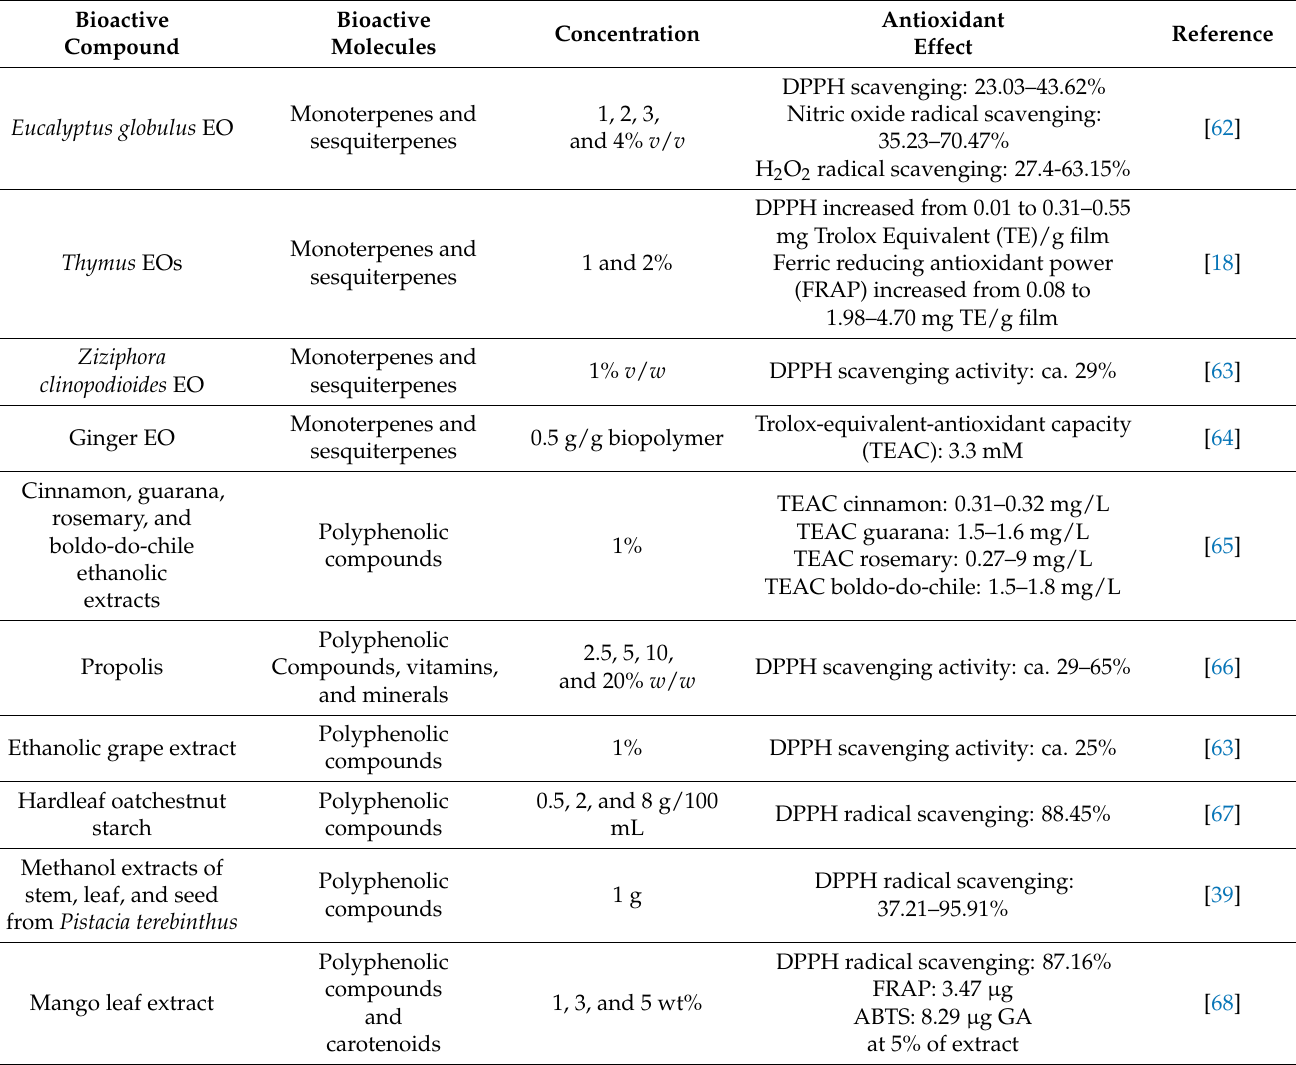
Table 2. Natural compounds with antioxidant capacity added to chitosan-based composites to produce bioactive films and